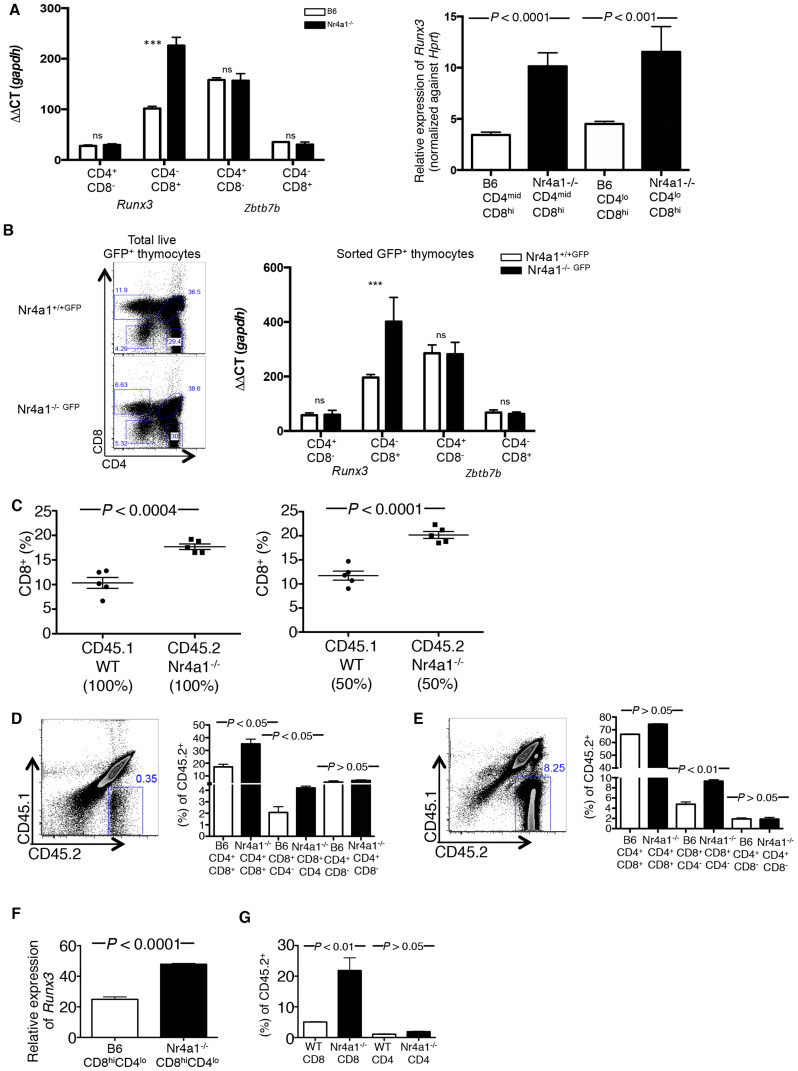
Nr4a1 intrinsically controls CD8+ T cell development through Runx3 expression.(A) qPCR measuring the levels of Runx3 and Zbtb7b RNA relative to Gapdh from sorted CD4+CD8− and CD4−CD8+ cells isolated from thymi of B6 versus Nr4a1−/− mice. qPCR measuring the levels of Runx3 RNA relative to Hprt from sorted CD4midCD8hi and CD4loCD8hi cells isolated from thymi of B6 versus Nr4a1−/− mice. (B) qPCR measuring the levels of Runx3 and Zbtb7b RNA relative to Gapdh from sorted GFP+CD4+CD8− and GFP+CD4−CD8+ thymocytes from Nr4a1+/+GFP+ versus Nr4a1−/−GFP+ mice. (C) B6, Nr4a1−/−, and B6:Nr4a1−/−1:1 mixed bone marrow chimeric mice were analyzed for the frequency of TCRβ+CD8+ Each symbol represents an individual mouse; small horizontal lines indicate the mean. (D) Isloated CD45.2 Common Lymphoid Progenitor (CLP) cells from B6 or Nr4a1−/− bone marrow were adoptively transferred into sublethally irradiated CD45.1.2 B6 hosts. Frequency of CD45.2+(left plot) DP(CD4+CD8+), TCRβ+ CD8+, and TCRβ+ CD4+ T cells (right graph) 7 days after transfer and (E) 14 days after transfer. (F) qPCR measuring Runx3 RNA levels in CD45.2 CD8hiCD4lo T cells isolated from the thymus 14 days after transfer. (G) Frequency of CD45.2 TCRβ+ CD8+, and TCRβ+ CD4+ T cells from peripheral lymph nodes 14 days after transfer. Data are representative of three separate experiments with at least three age and sex matched mice per group. Small horizontal lines indicate the mean. P value, unpaired, two-tailed t-test. ns(p > 0.05), *p < 0.01, **p < 0.001, ***p < 0.0001.